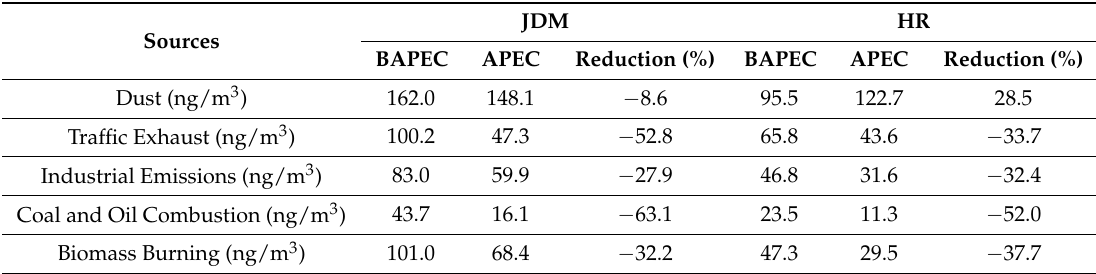
Table 3. Averaged concentration of metallic elements in PM 2.5 for the five factors for before and during the APEC summit in Beijing urban site (JDM) and suburban site